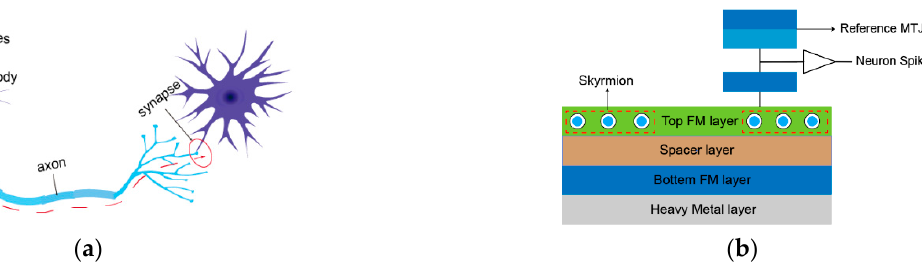
Figure 2. Analogy between biological neuron and skyrmion neuron: ( a ) a biological pre-neuron; ( b ) skyrmion-based LIF neuron [29].